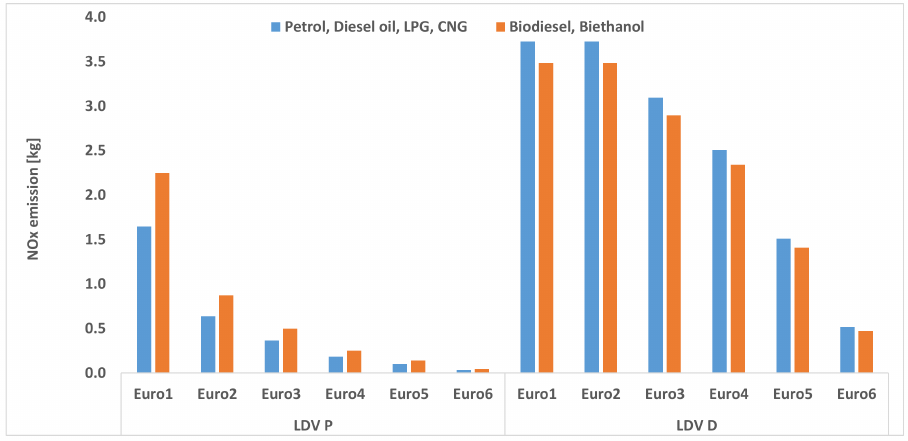
Figure 9. Comparison of NOx emissions from LDVs depending on Euro standard and fuel type.